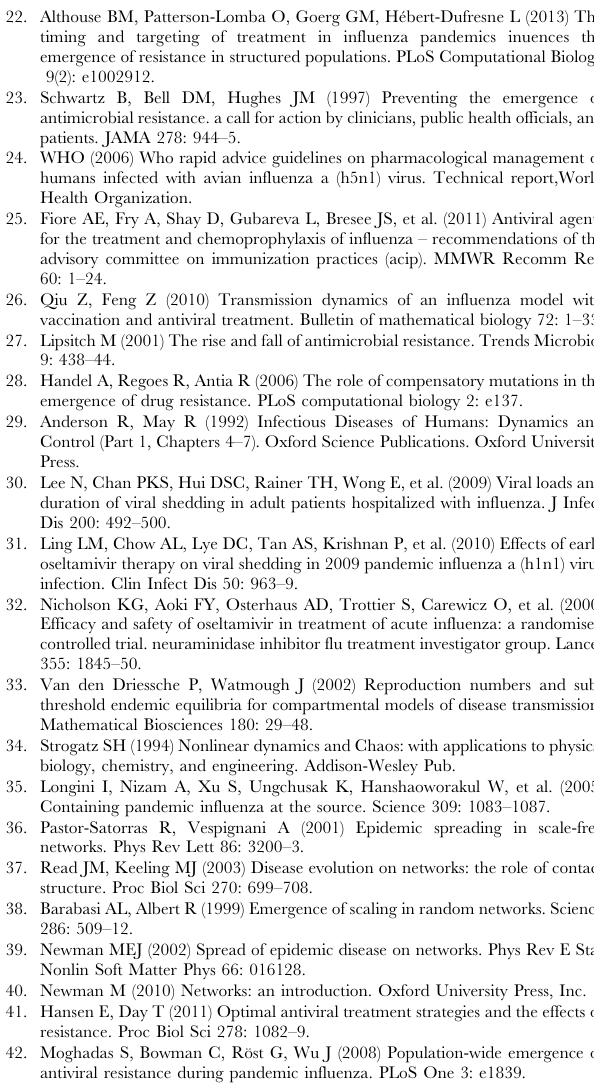
Figure S9 Prevalence as a function of r and w . Figure S10 I 3 r ( r ) for 1 v R r 0 v 1 = (1 { r (cid:3) c ) and for w 1 = (1 { r (cid:3) c ) . R r 0 (EPS) Text S1 Analytical derivation of reproduction numbers; analogous model; analytical derivations regarding the stability of the system; and analytical derivations regarding the optimal treatment